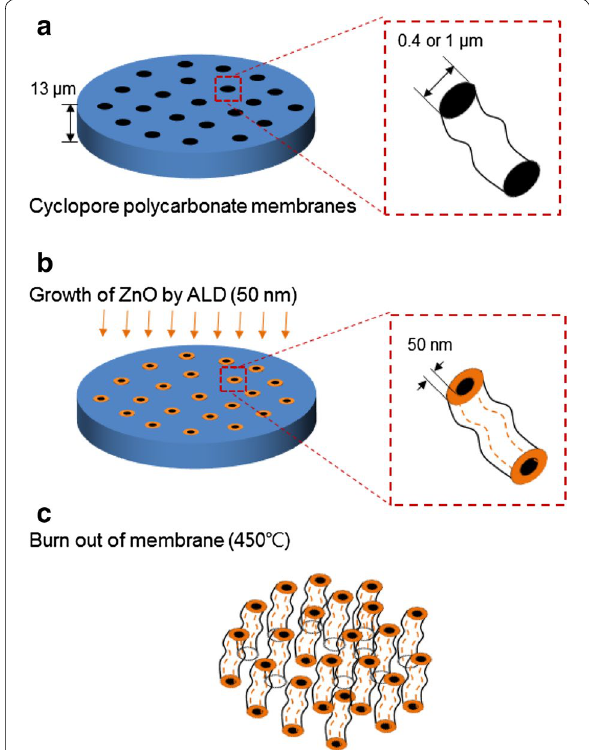
Fig. 1 Schematic illustration of steps used for the preparation of hol‑ low ZnO NWs. a Cyclopore polycarbonate membranes. b Growth of ZnO by ALD (50 nm). c Burn out of membrane (450